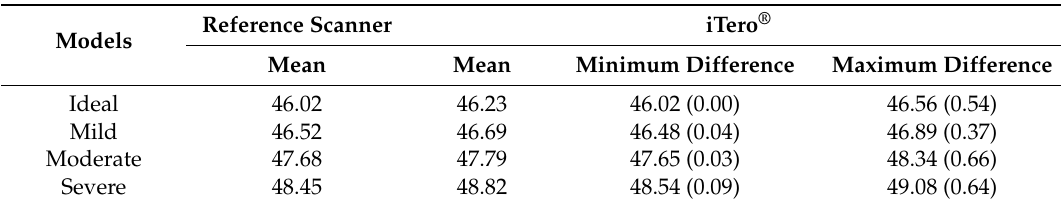
Table 2. Comparison of differences in intermolar widths between iTero ® and the reference scanner (unit: mm).